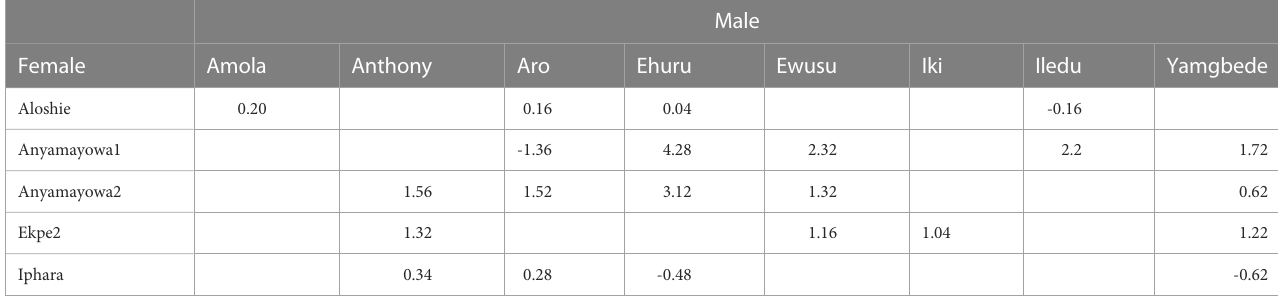
TABLE 6 Genomic prediction cross performance among the 13 top ranking landraces for multi-trait performance based on FAI-BLUP